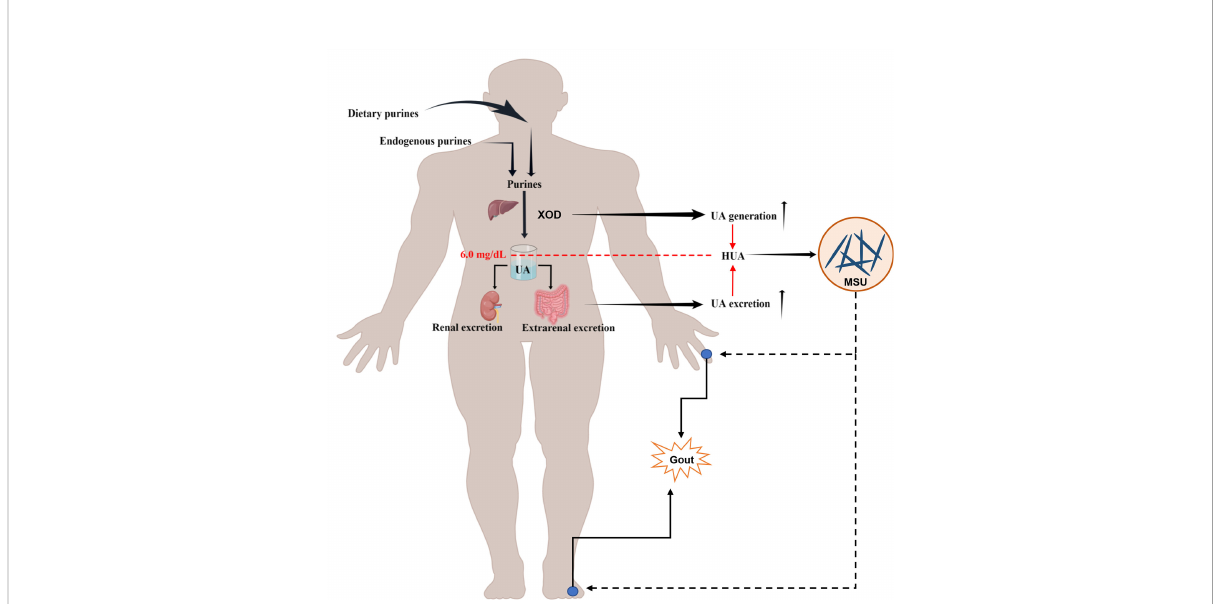
FIGURE 1 Schematic diagram of the pathophysiological model of HUA and gout formation. HUA (serum UA levels >6.0 mg/dl) is caused by an imbalance of UA metabolism, including an increase in UA production through endogenous purine and exogenous purine metabolism and a decrease in